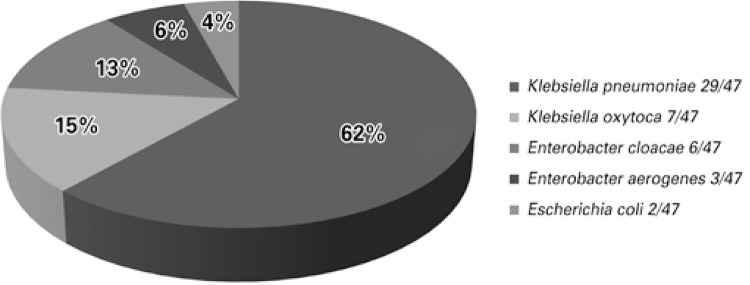
Distribuição de enterobactérias isoladas com resistência aos carbapenêmicos